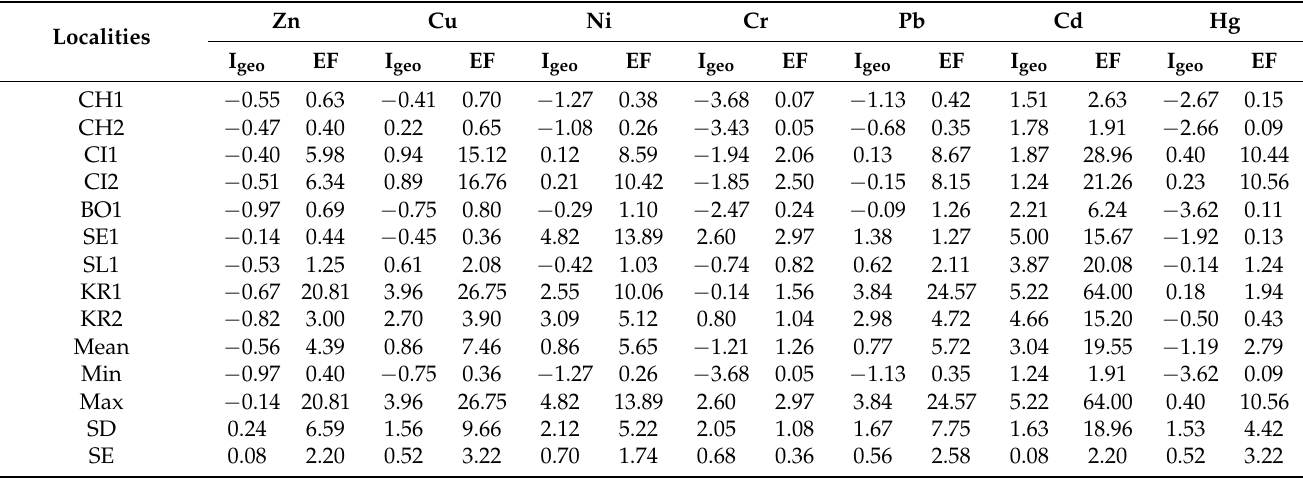
Table 3. The index of geoaccumulation (I geo ) and enrichment factor (EF) for risk elements in the soil of the investigated localities